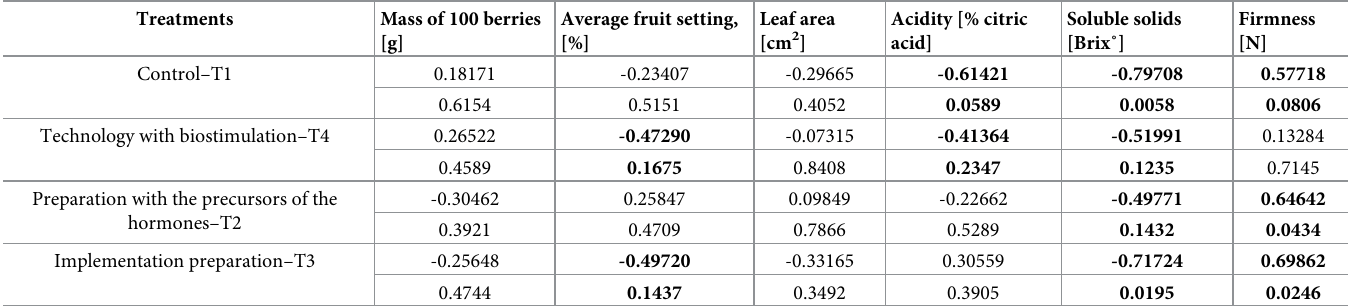
Table 4. Pearson’s correlation coefficients for multivariate analysis of the impact of fruit yield, t . ha -1 for blueberry fruit parameters. Treatments